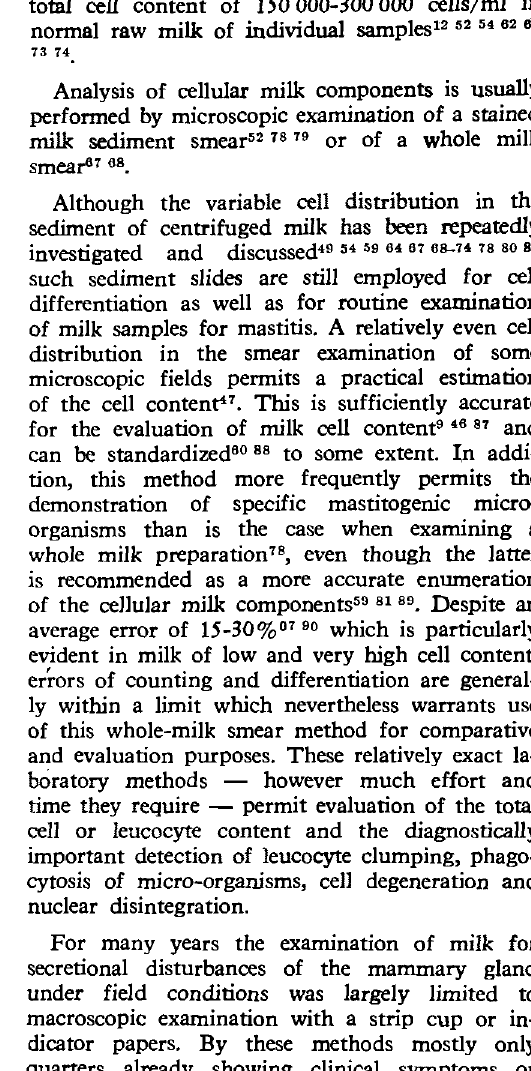
TABLE 3.-'--THE TOTAL CELL CONTENT/ML OF NORMAL RAW BOVINE